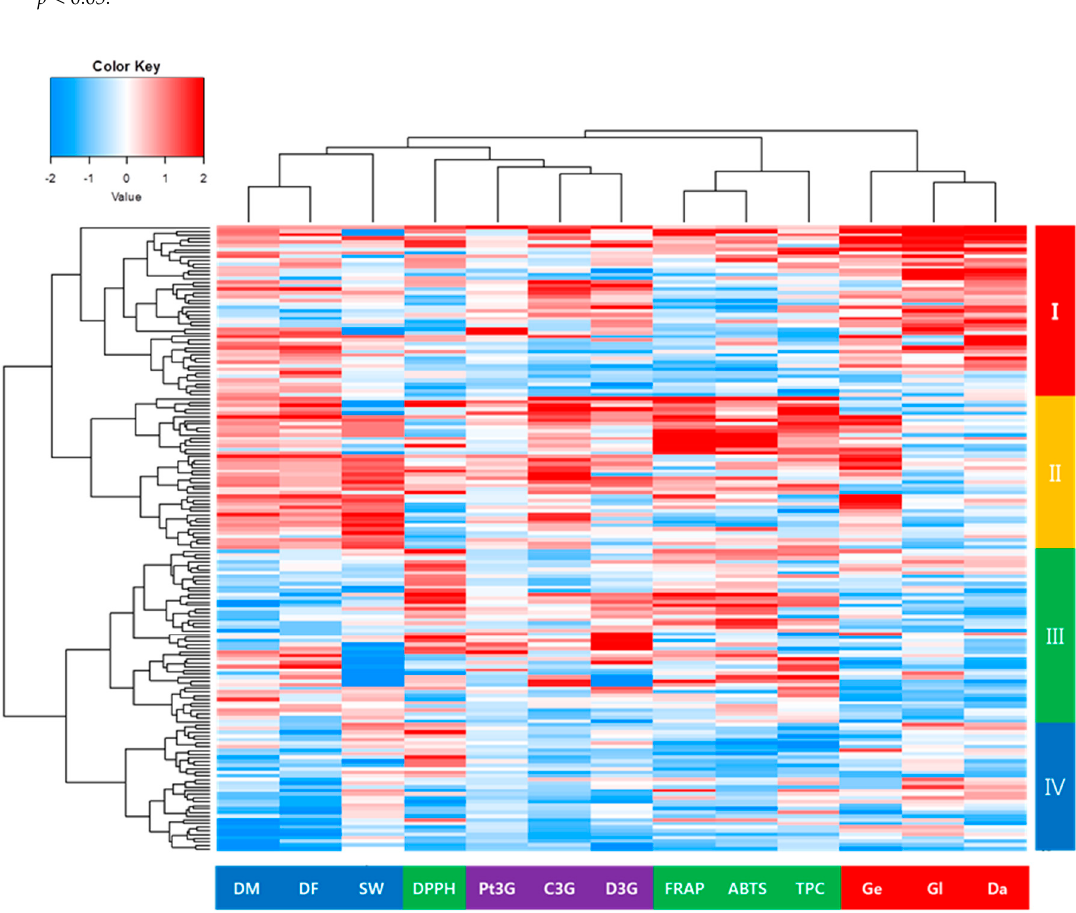
Figure 3. Hierarchical clustering analysis of agricultural traits, phytochemicals, and antioxidant activities in 172 Korean black soybean landraces.